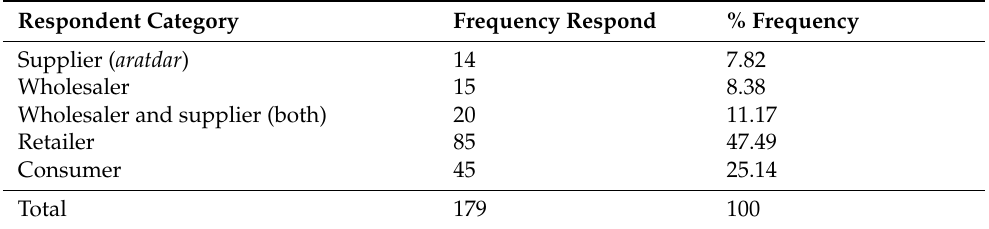
Table 1. Characteristics of respondents interviewed in seven selected fish markets.